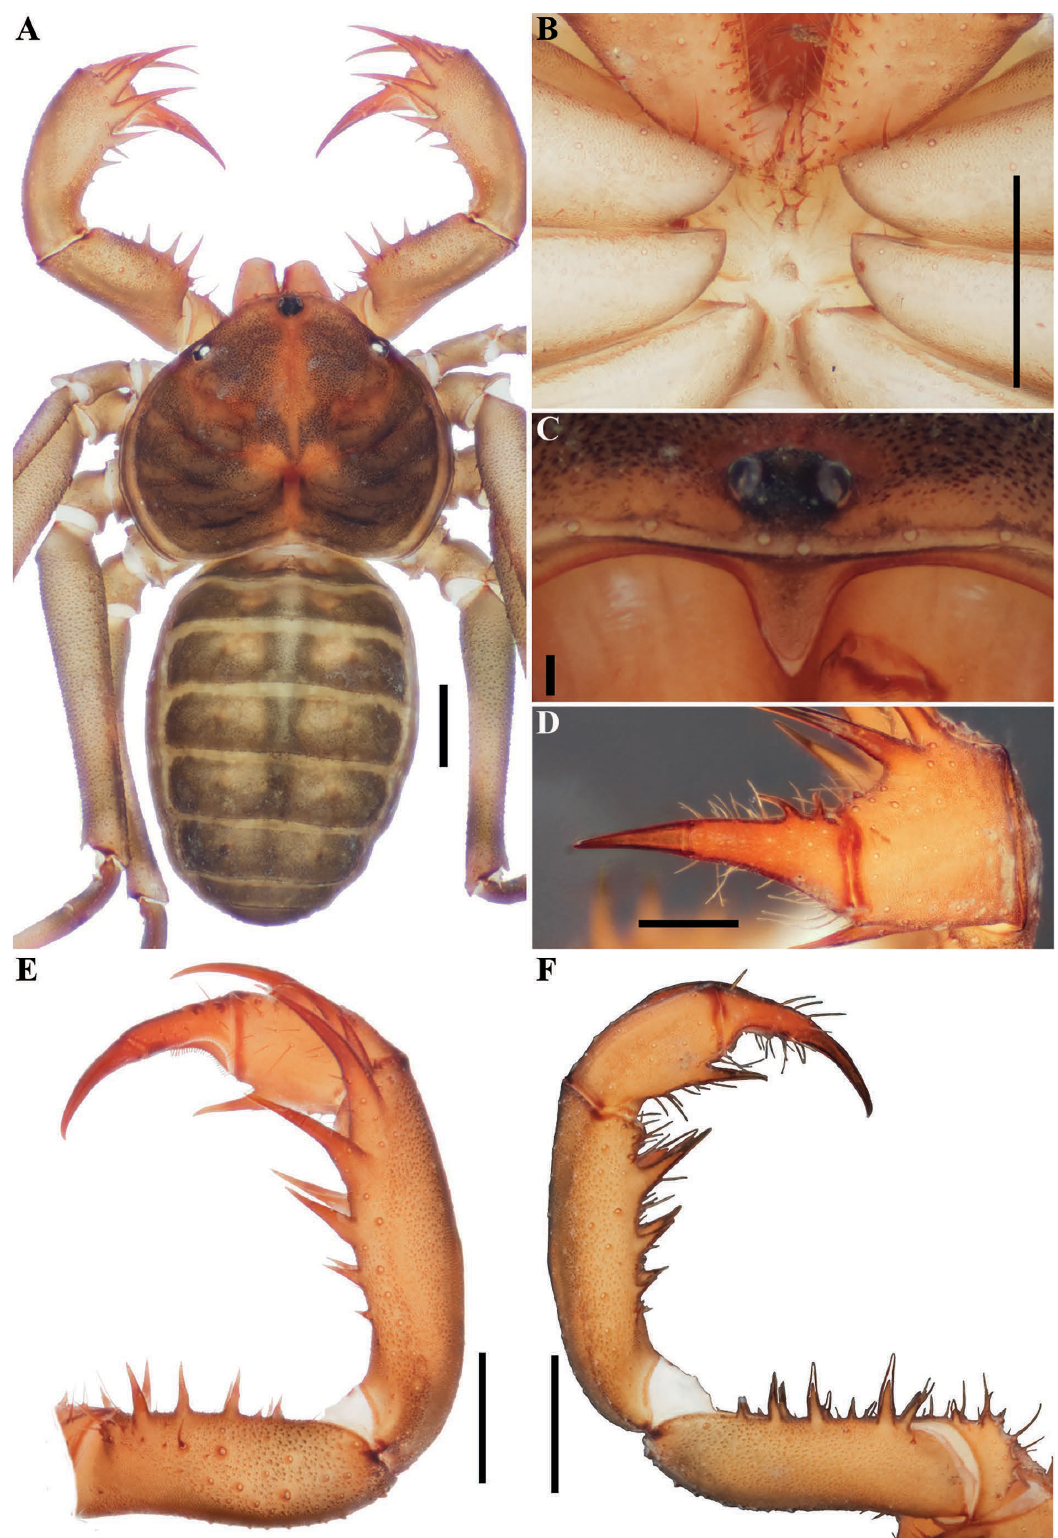
Fig. 110. Sarax gravelyi sp. nov. (AMCC [11995]), general morphology, ♀. A . Habitus, dorsal